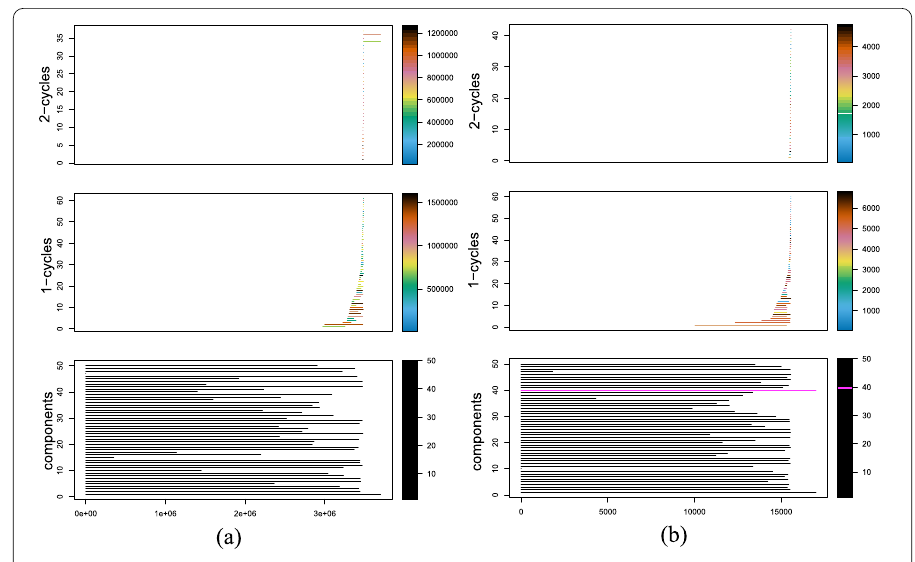
Figure 9 Persistence Barcodes. ( a ) 0-, 1-, and 2-dimensional barcodes (bottom, middle, and top respectively) of the Asian net migration network. ( b ) 0-, 1-, and 2-dimensional barcodes of the Asian net remittance network. The colors in the 0-dimensional barcodes represent eventual component membership, while colors in the 1- and 2-dimensional barcodes reflect the standard deviation of the edge weights in the cycle